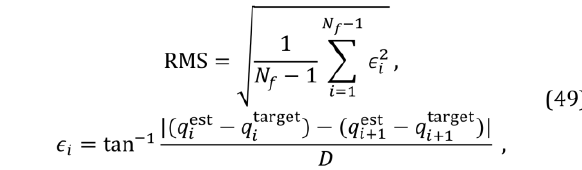
Figure 13. Illustrative examples of the estimated gaze tracking signal, in the scene camera coordinates. Blue and green lines show the horizontal and vertical coordi- nates. Estimated blinks are shown as vertical red dotted lines. The black curve shows the sigmoid values of Eq. (2), scaled between 0 and 500 which is indicated as a dashed vertical line. Left panel is from the saccade task and right panel from the smooth pursuit task.